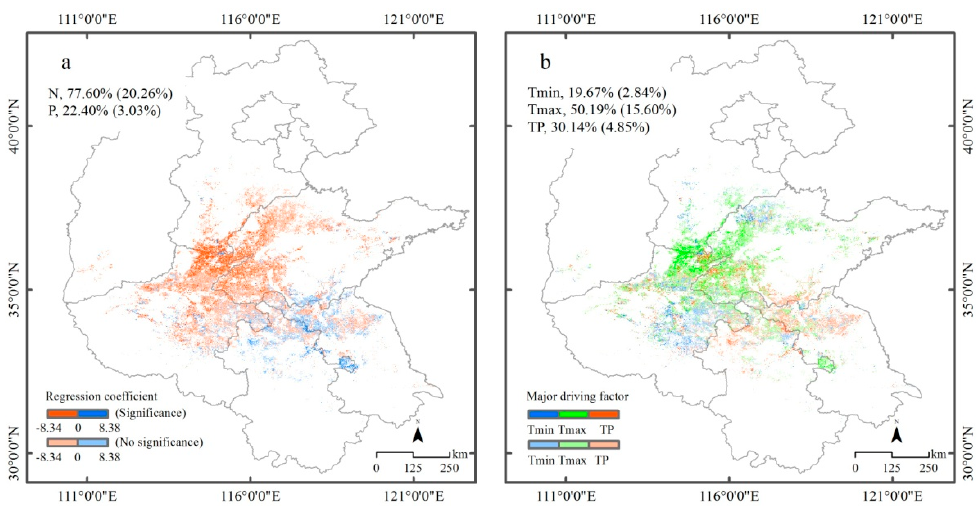
Figure 12. Spatial distribution of multiple regression coefficient between GUD and climatic factors ( a ) and main climate-driven factors to GUD ( b ) during the period of 2010–2015. Percentage of positive (P) and negative (N) correlations and corresponding significant correlations (P < 0.05, in parentheses) are shown in Figure 12a. Percentage of different major driving factors ( T min , T max , and TP ) controlling area and corresponding significant area (P < 0.05, in parentheses) are shown in Figure 12b.